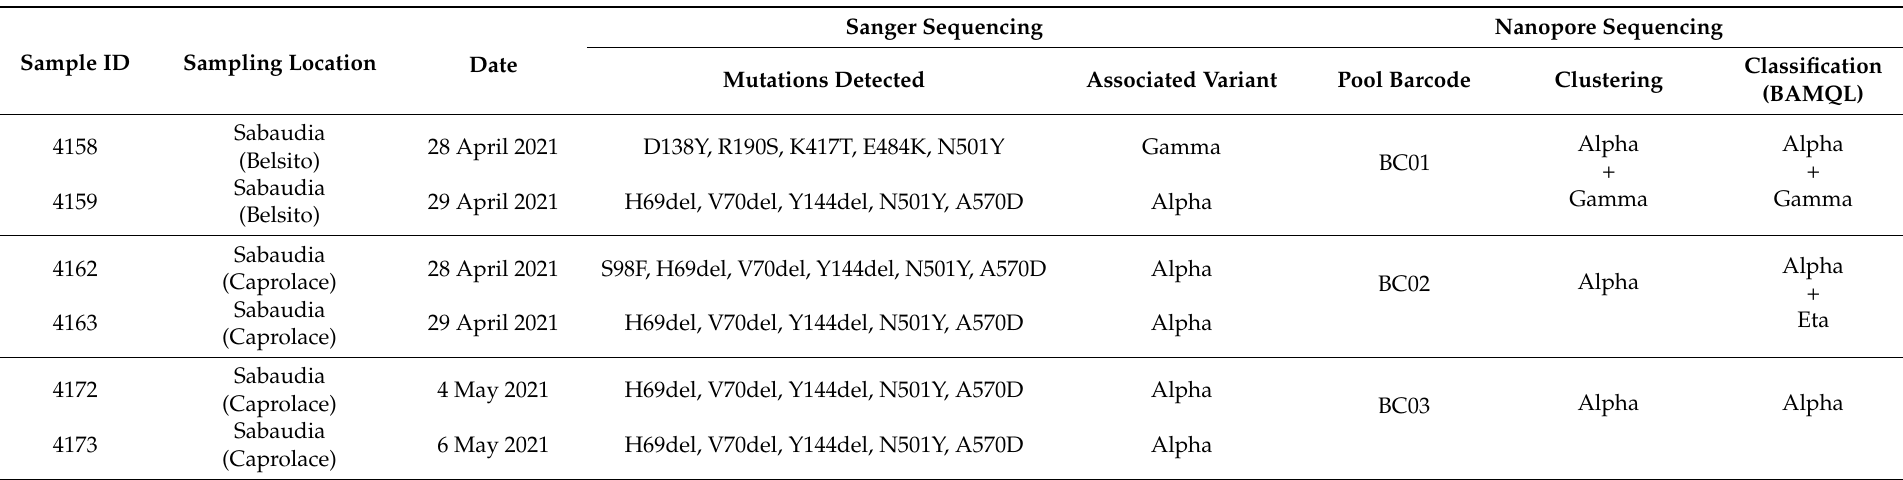
Table 2. Samples under study and results obtained by Sanger and nanopore